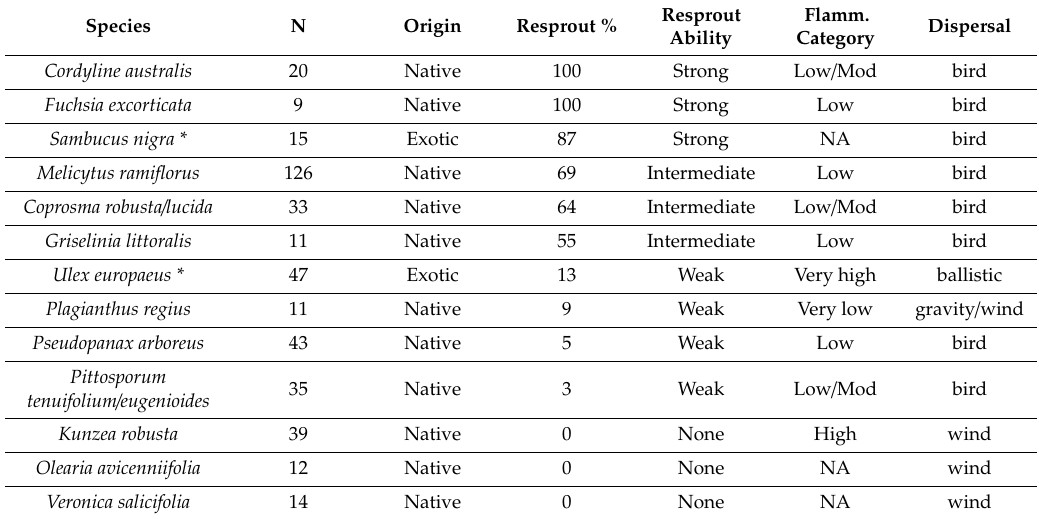
Table 1. Classification of resprouting ability for the most abundant species ( n ≥ 9), along with